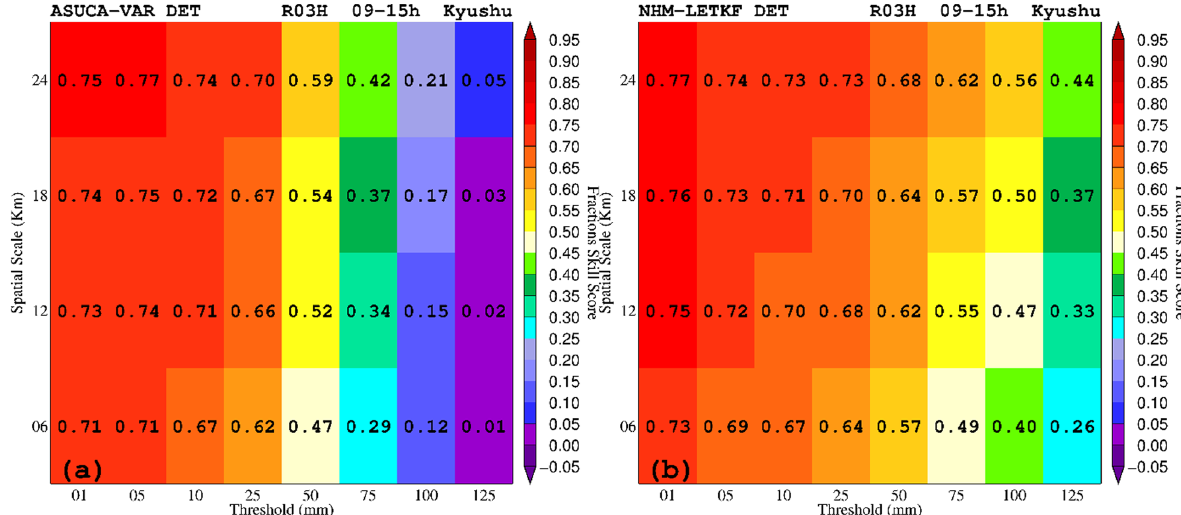
Fig. 2 FSSs of the consecutive 3-h precipitations forecasted by ASUCAR-VAR and NHM-LETKF against the R/A observations between 00 and 09 JST July 4th 2020 over the Kumagawa catchment. (Reproduced Duc et al.